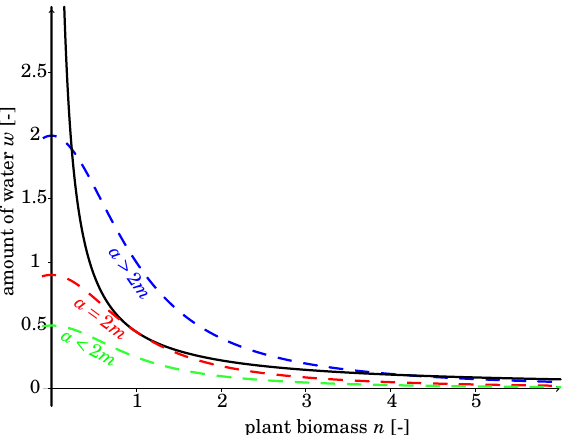
Figure A1. The nullclines of the nondimensionalized nonspatial system (see Equation (5)) are shown. Dashed lines represent the water nullclines, while the solid lines represent the biomass nullclines. Note that one solid line is represented by the